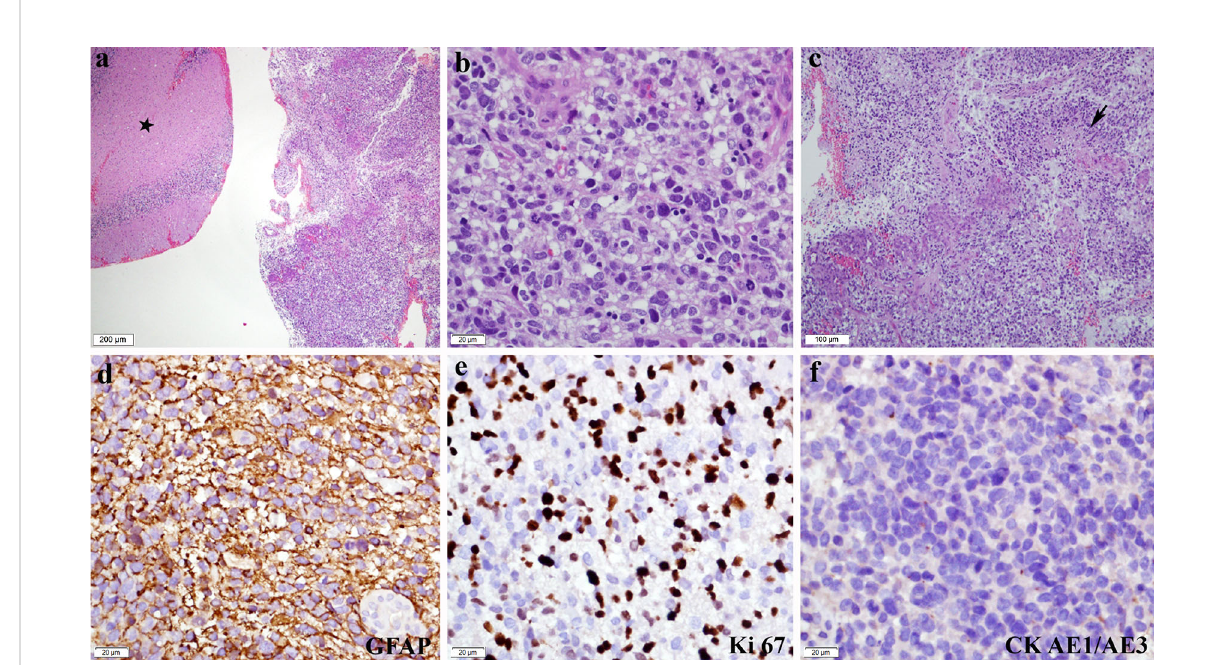
FIGURE 5 Histopathological and immunohistochemistry features of glioblastoma. (A) Unremarkable cerebellar tissue (asterisk) with adjacent tumour tissue (H&E*, ×40). (B) Composed of diffuse sheets of malignant cells exhibiting pleomorphic hyperchromatic nuclei with inconspicuous nucleoli and moderate cytoplasm. Mitotic fi gures are frequently seen, including the atypical form (H&E, ×400). (C) Microvascular proliferation and geographical necrosis (arrow) are also noted (H&E, ×100). Immunohistochemically, the malignant cells showed (D) diffuse GFAP** positivity (GFAP, ×400). (E) Ki 67 proliferative index is high (Ki67, ×400), while (F) CK*** AE1/AE3 is negative (CK AE1/AE3, × 400). *Haematoxylin and eosin stain, **glial fi brillary acidic protein, and ***cytokeratin